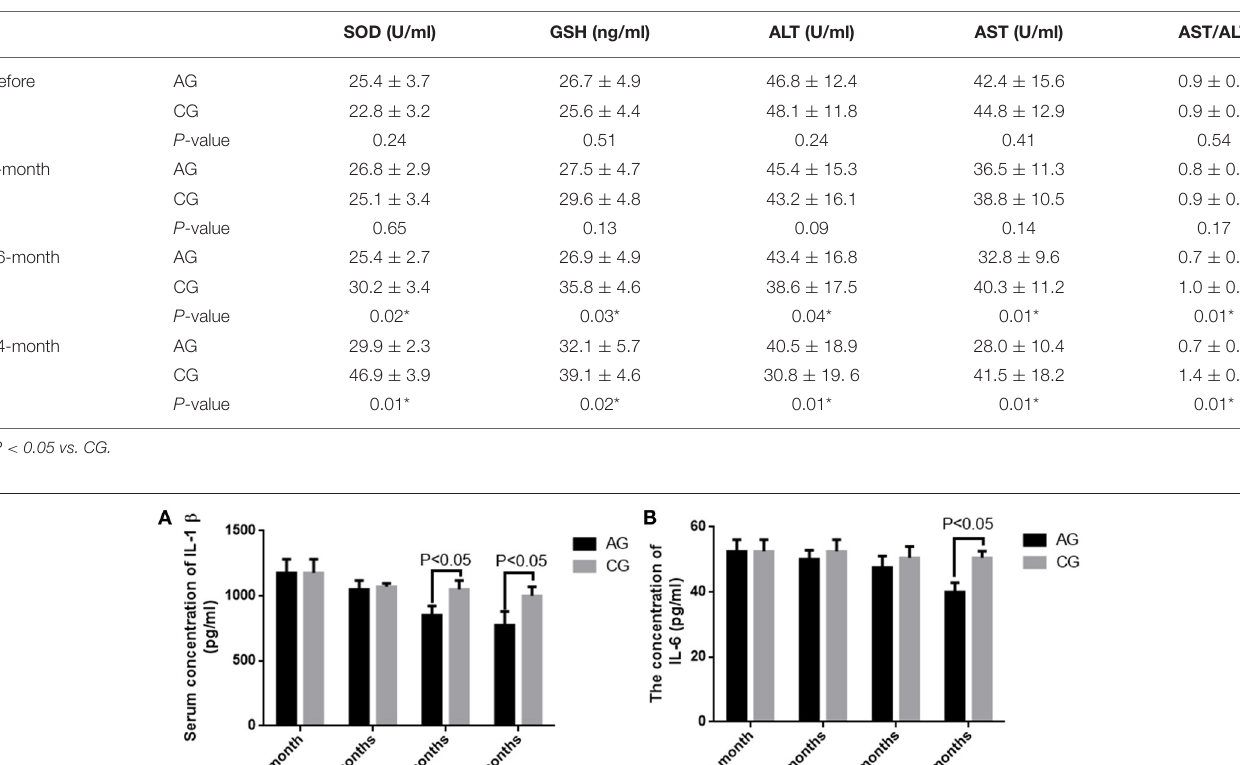
TABLE 3 | Biochemical parameters of enzyme activities.